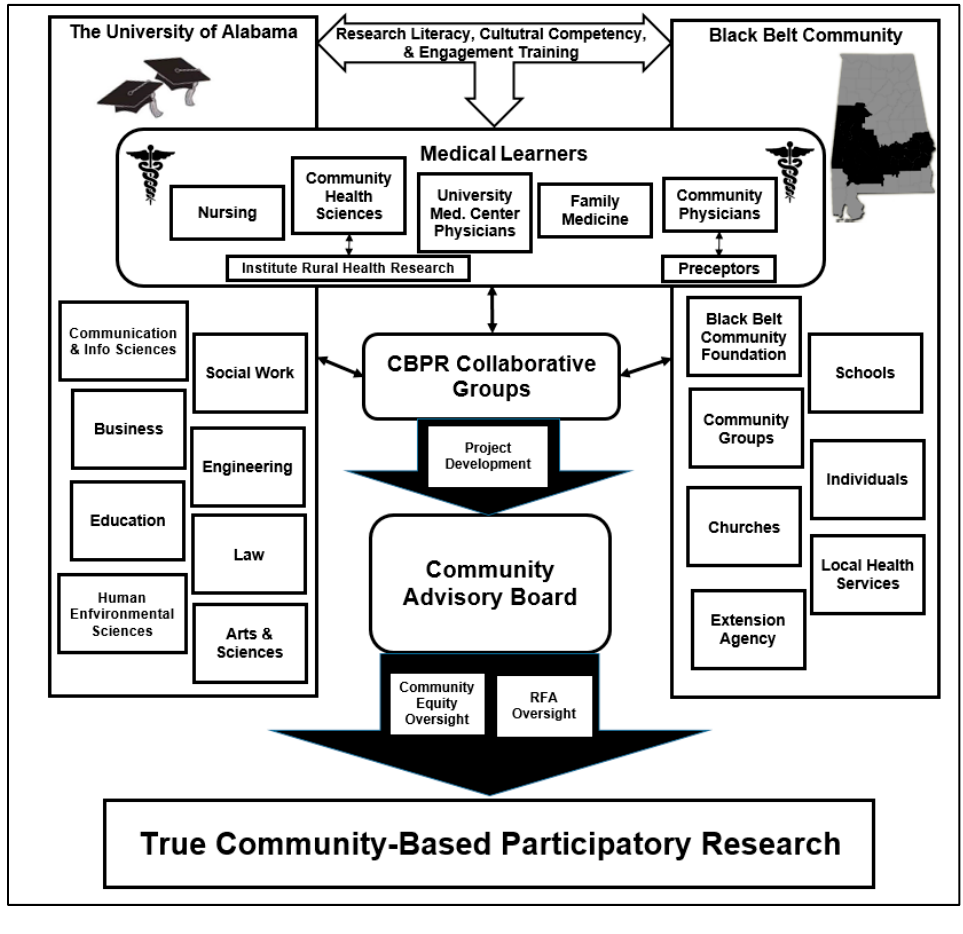
Figure 1. Project Using New Interventions Together to Eliminate Disparities (UNITED) organizational